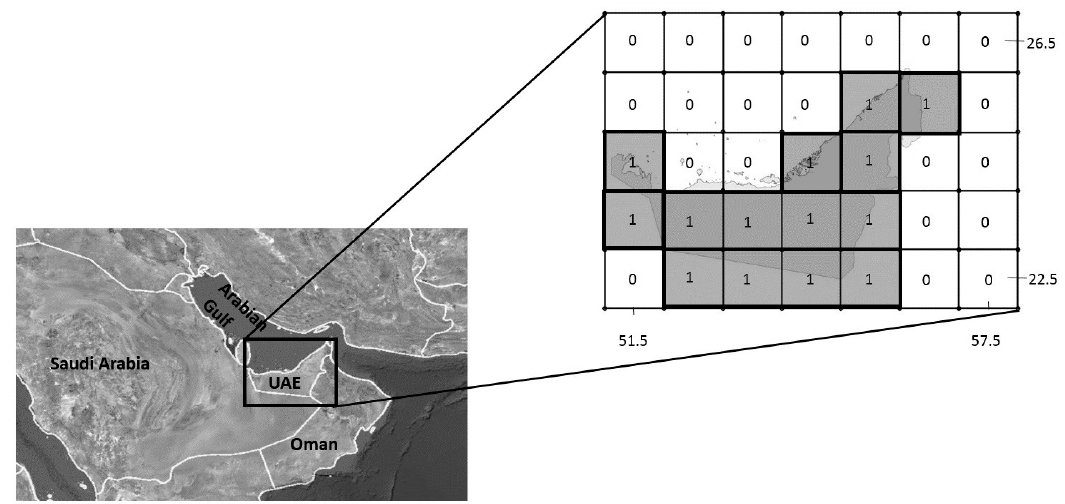
Figure 2. Study area overlaid with The Gravity Recovery and Climate Experiment (GRACE) grid.